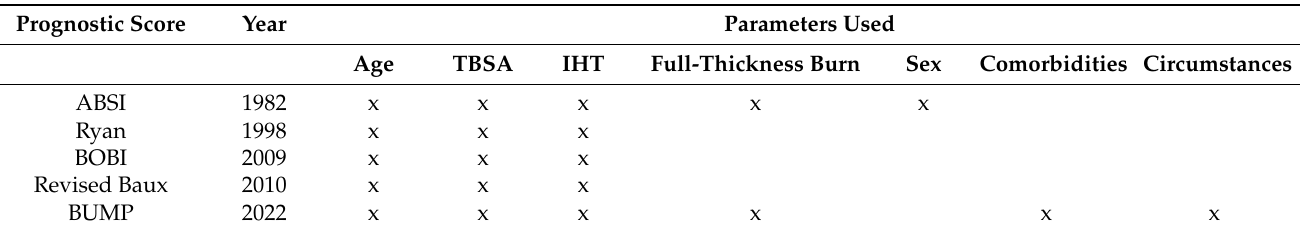
Table 1. Mortality prediction scores.